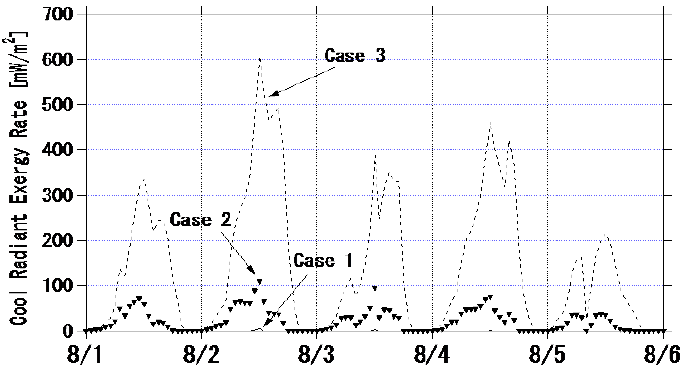
Figure 7. Cool radiant exergy input